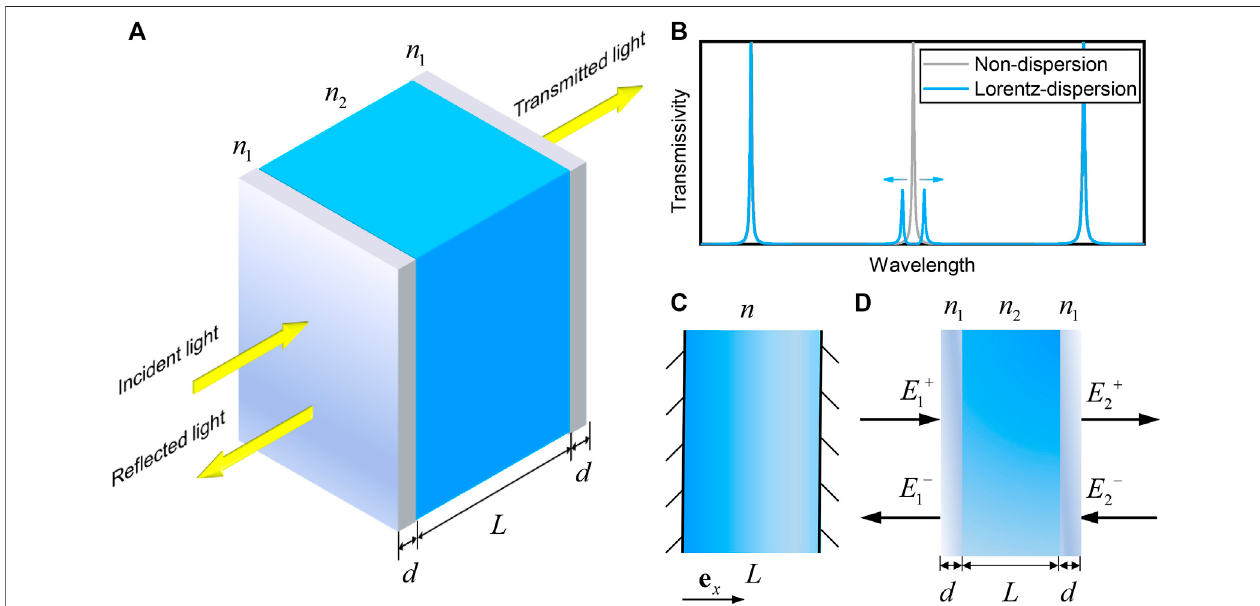
FIGURE 1 | Schematic diagram for a Fabry-Perot optical microcavity used to probe cavity-atom interactions. (A) Schematic diagram for a practical Fabry-Perot optical microcavity system involving a dielectric medium embedded with atoms sandwiched between two high-re fl ection and loss-free mirrors. A classical splitting in spectrum can be observed in this model. (B) Diagram for transmission spectrum of optical microcavity exhibiting the splitting for Lorentz-dispersion cavity medium. (C) Schematic diagram for an ideal Fabry-Perot optical microcavity system to analyze theoretically the cause of classical spectral splitting observed in the practical optical microcavity system. (D) Schematic diagram for solution to the transmission/re fl ection spectrum in the Fabry-Perot optical microcavity system using a transfer- matrix method.